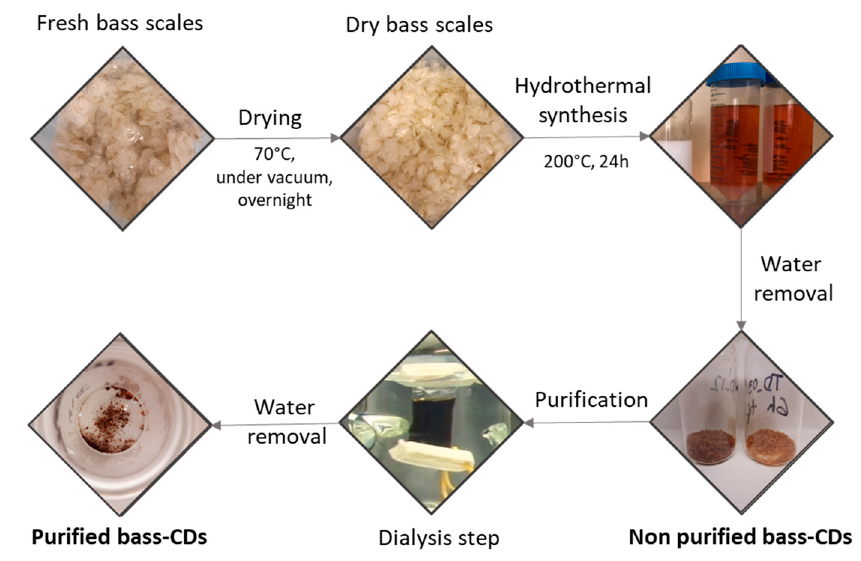
Figure 1. Synthetic pathway for the bass carbon dots